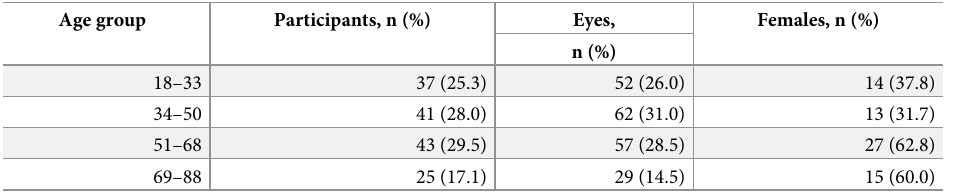
Table 1. Distribution of participants by age group and